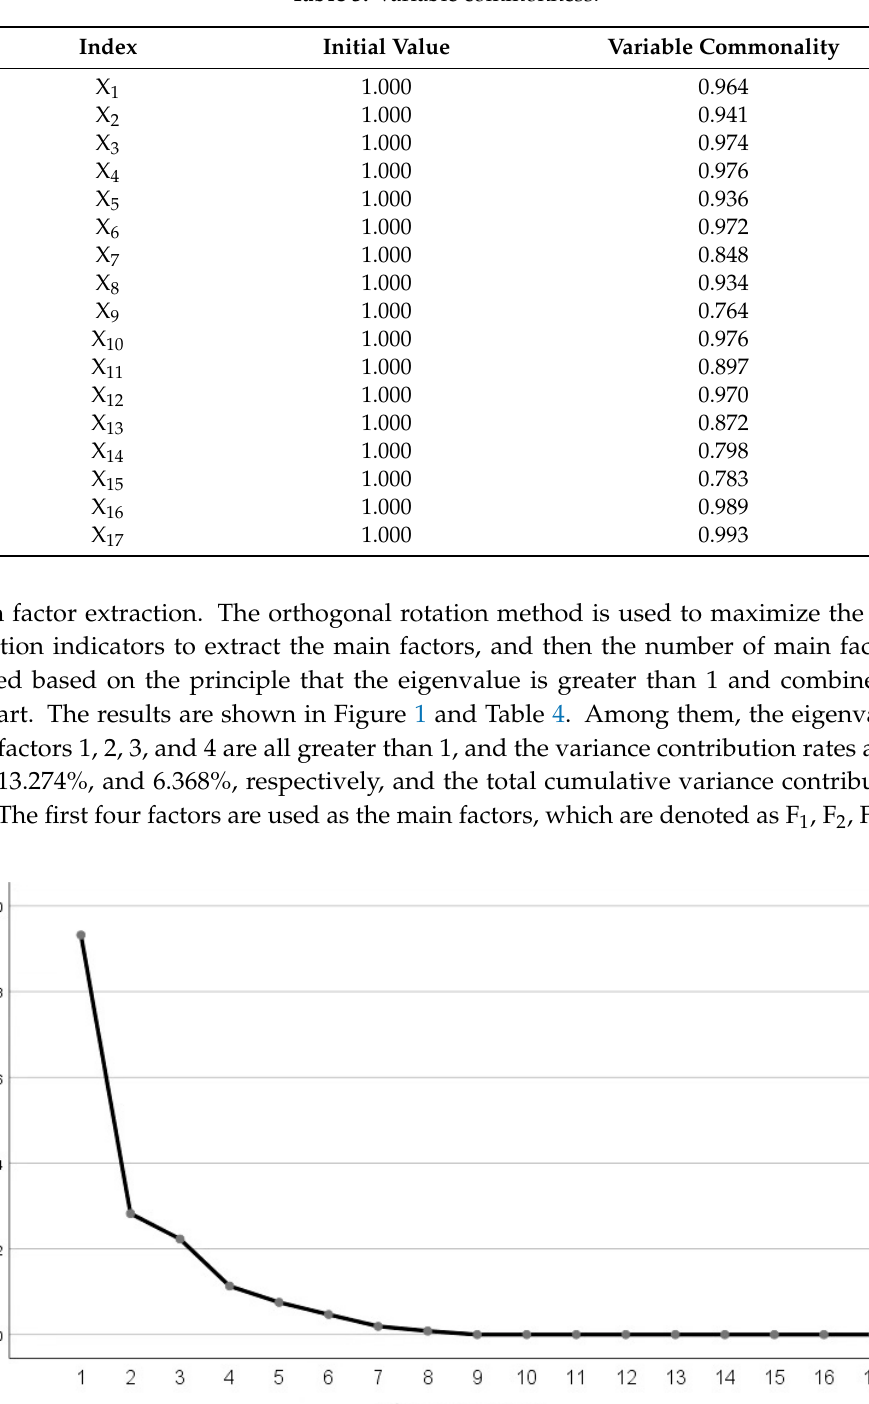
Table 3. Variable commonness.